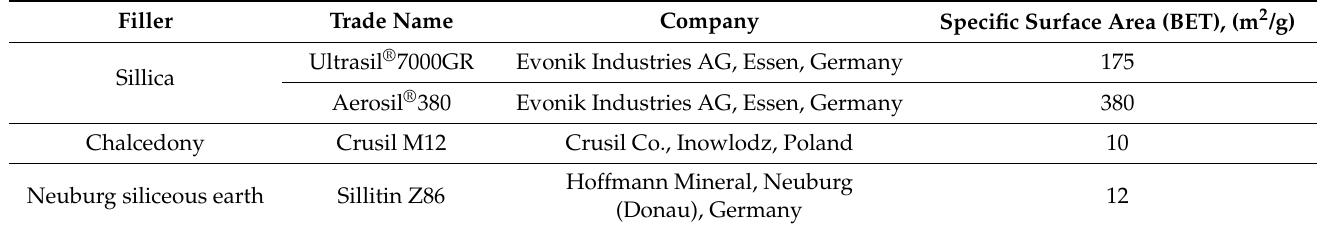
Table 2. The characteristic of the